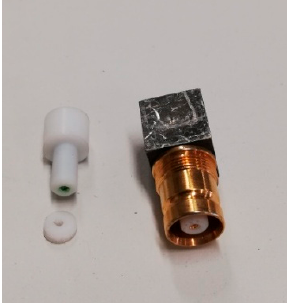
Figure 4. Sample 1 before (right) and after (left) acid digestion. Gold content of different type of connectors (sample 2) were reported in Table 2. Table 2. Au content within different types of connectors (sample 2).